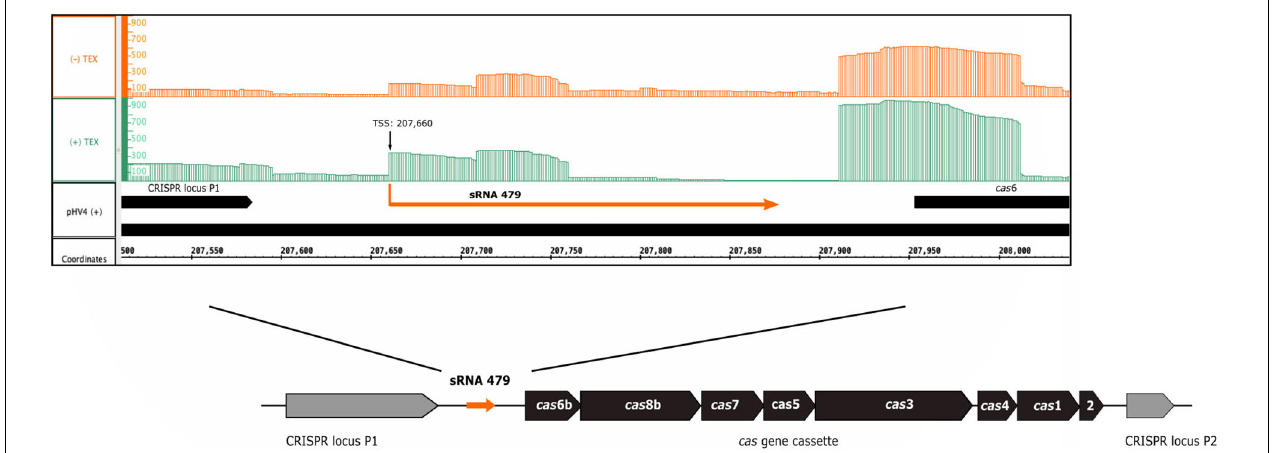
FIGURE 1 | Genomic location of s479. The sRNA 479 is encoded on the genomic plasmid pHV4, and as the read abundance shows (Jaschinski et al., 2014; Babski et al., 2016), transcription initiates at position 207,660. Transcription start site data (TSS) together with the previously obtained RNomics data (Straub et al., 2009) show that the s479 gene is 213 bp long. Location of s479 is noteworthy, as it is encoded in the intergenic region between a CRISPR locus and the cas gene cassette. Reads obtained from RNA treated with terminal exonuclease (+TEX) are shown in green, and reads from untreated RNA ( − TEX) are shown in orange. Comparison of reads from both fractions allowed us to determine the TSS (indicated by an arrow). Genome coordinates and annotated genes of the main chromosome plus strand are shown in black at the bottom.